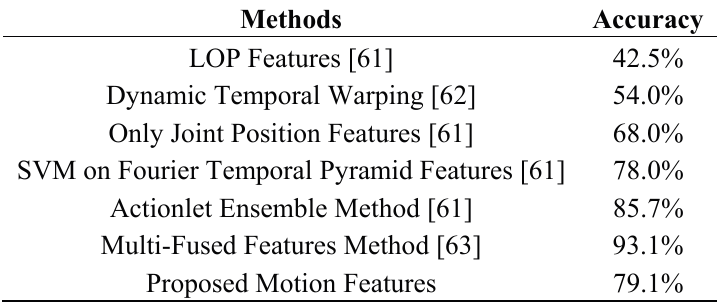
Table 14. Comparison of recognition accuracy on MSRDailyActivity3D